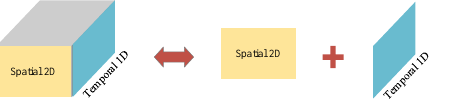
Figure 2. The illustration that standard 3D convolution can be separated into two parts: spatial convolution and temporal